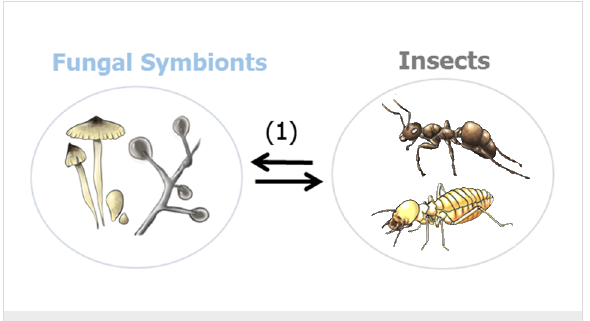
Figure 8: Beneficial interactions (1) between fungal symbionts and